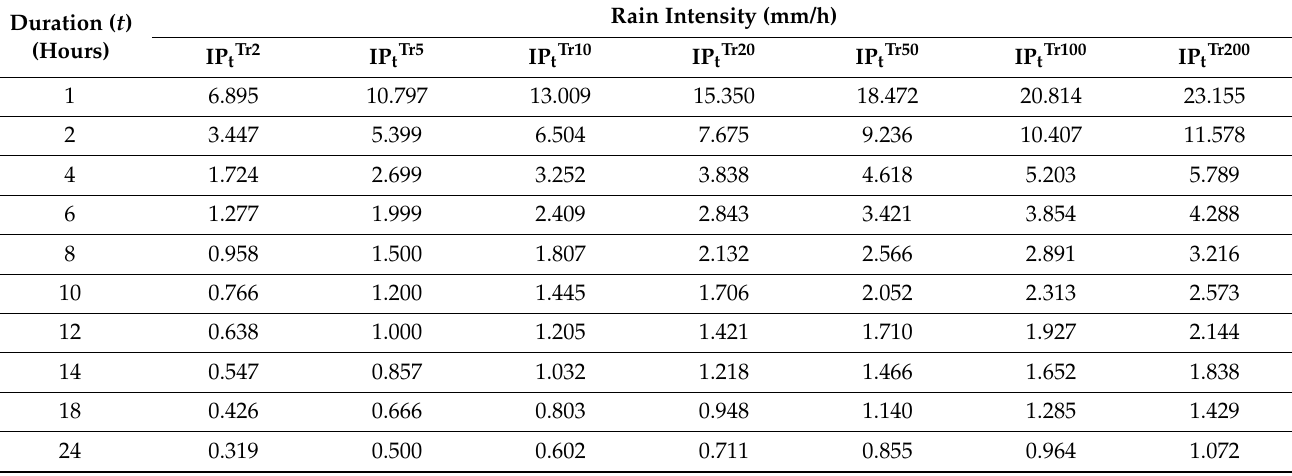
Table 6. Rainfall intensity (IPtTr) (mm/h) for different return periods of Tr years and for different durations of t